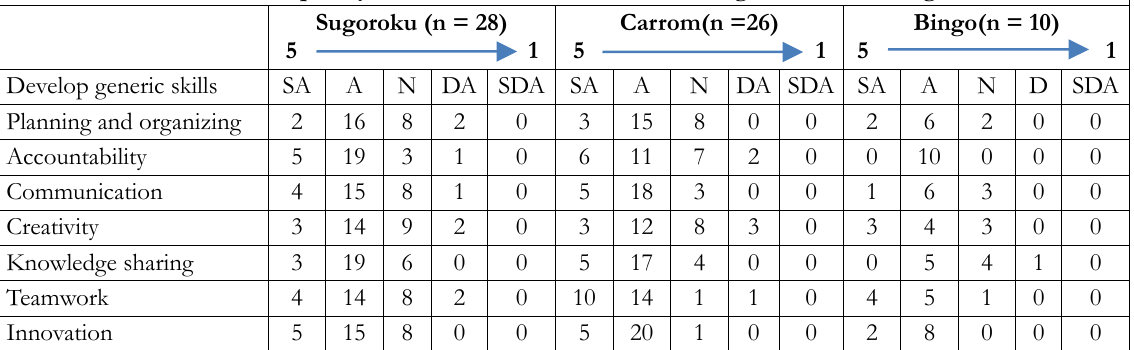
Cross Frequency Table of Self Assessment for Design Based